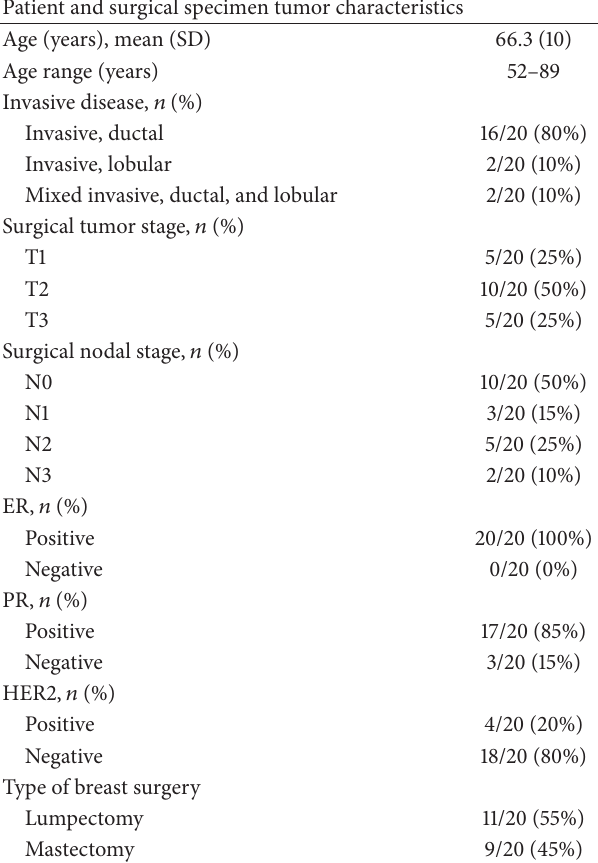
Table 1: Clinical and pathological characteristics of patients who enrolled in the